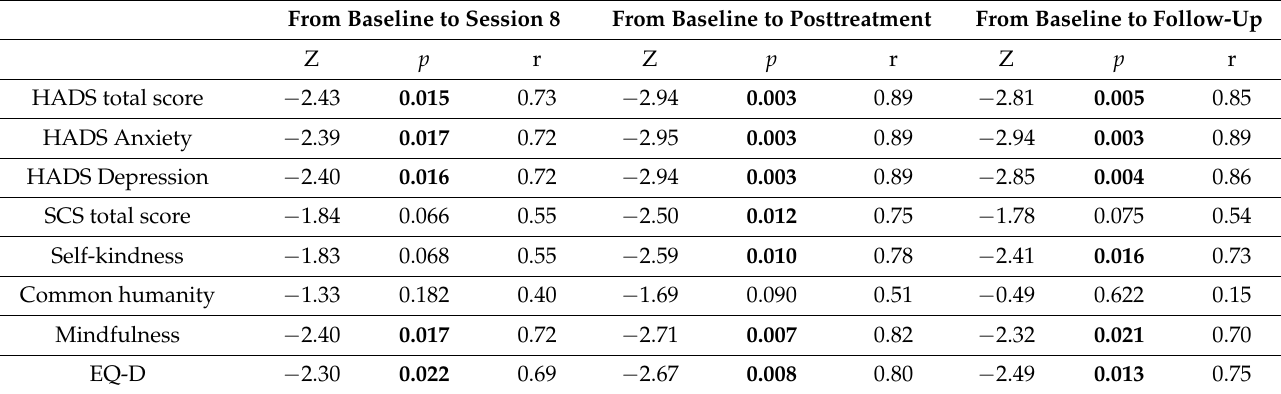
Table 2. Statistical significance of the changes in the study